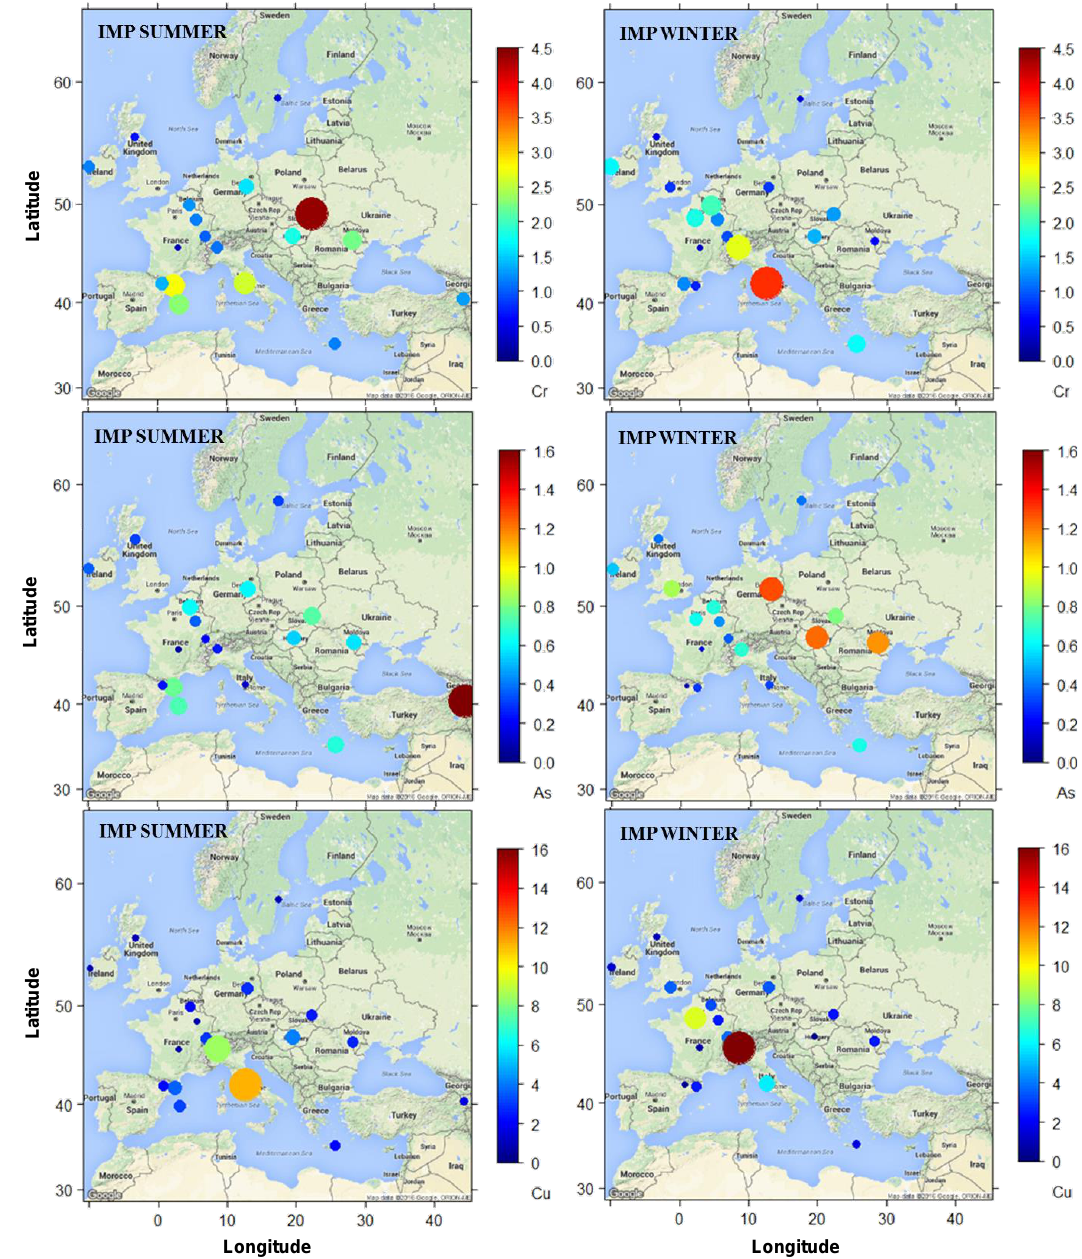
Figure 14. Spatial distributions of the mean concentrations (in ngm − 3 ) of Cr, As, and Cu, determined at each site during the summer and the winter EMEP IMPs. The diameter of the circles is proportional to the